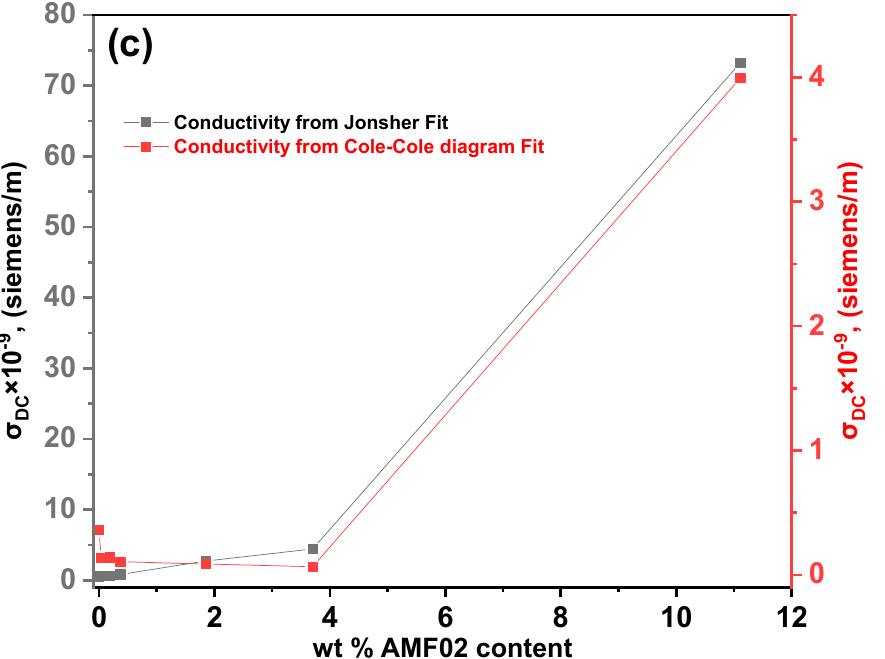
Figure 13. ( a ) AC real and imaginary part of dielectric impedance; ( b ) Cole–Cole diagrams; and ( c ) DC conductivity vs. wt% AMF02 fillers.